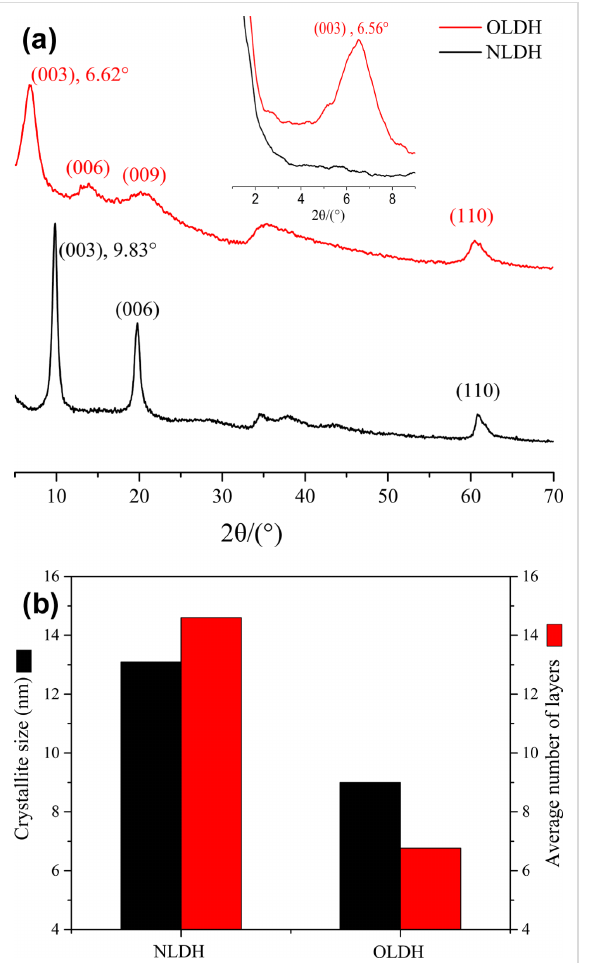
Figure 6: (a) XRD patterns (WAXS: 5–70°, SAXS: 1–10°) and (b) crys- tallite size (thickness in the normal direction to the (00 l ) planes) of NLDH and OLDH.